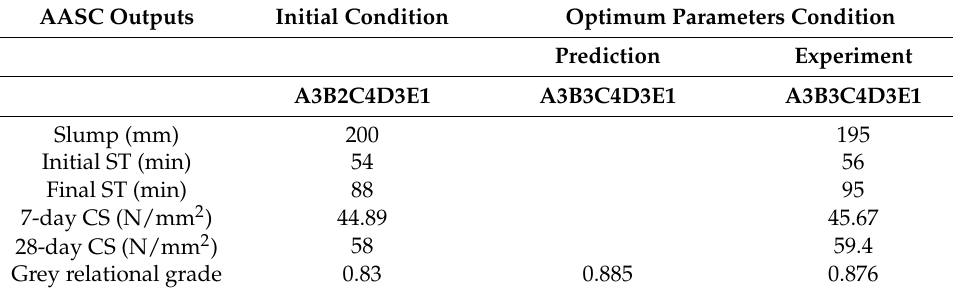
Table 8. Results of confirmation experiment.